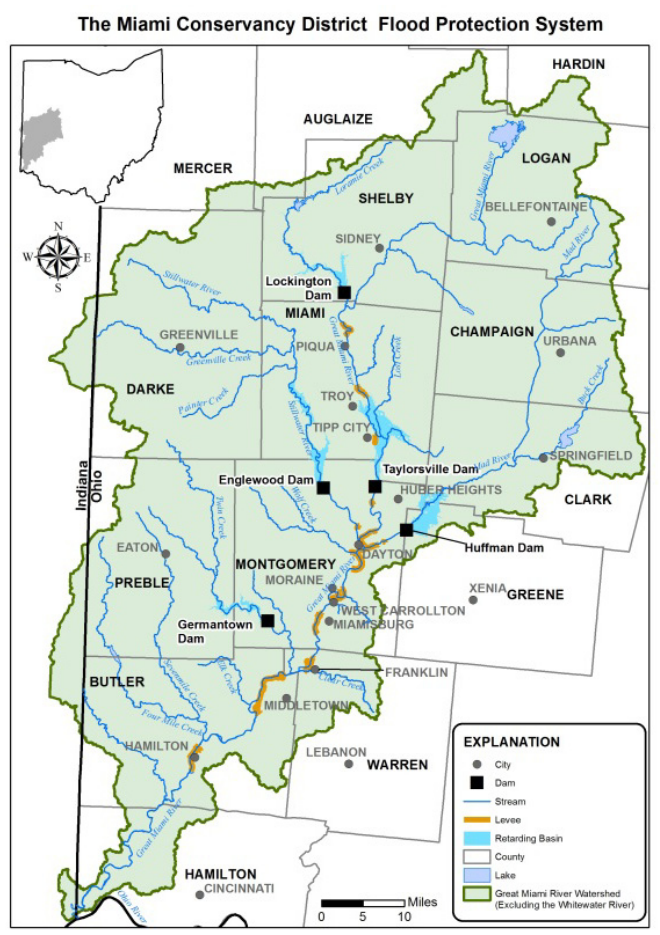
Figure 1. The Great Miami River Watershed. (Source: Miami Conservancy